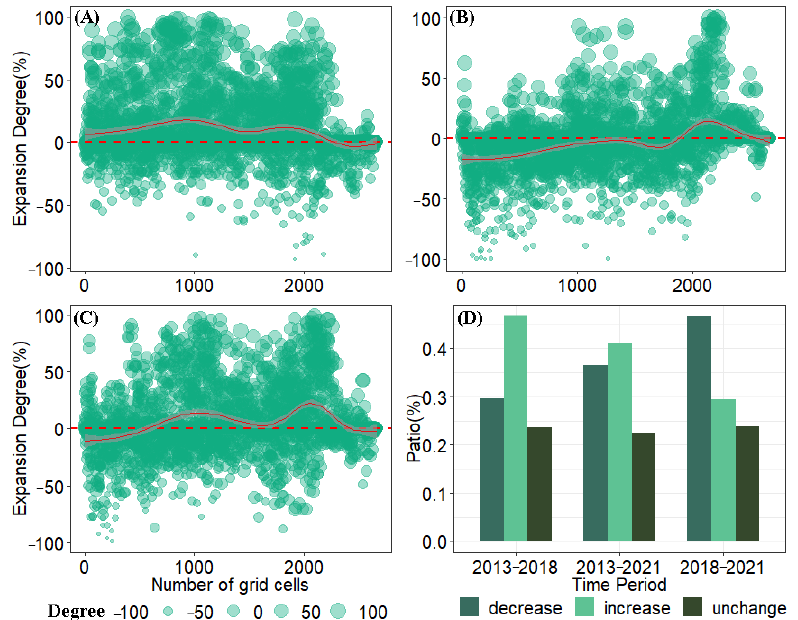
Figure A4. Plot showing the expansion of cage mariculture in the study area at the grid scale including ( A ): 2013–2018, ( B ): 2018–2021, ( C ): 2013–2021, and ( D ): Patio changes in cage mariculture during the different periods.